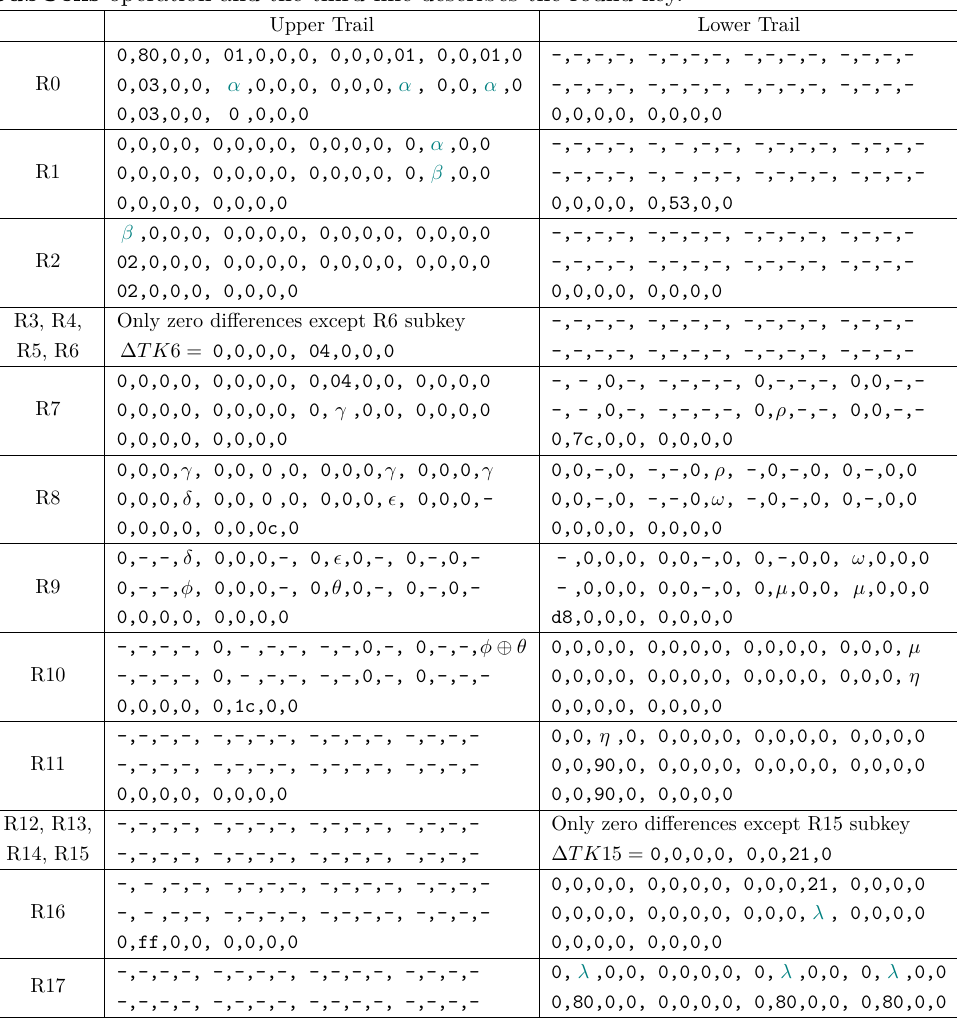
Table 3: Characteristic on 18 rounds of skinny -128-256. Values are represented in hexadecimal, greek letters are variables used in the sum, and dashes are unspecified differences. For each round, the two first lines describe the state before and after the SubCells operation and the third line describes the round